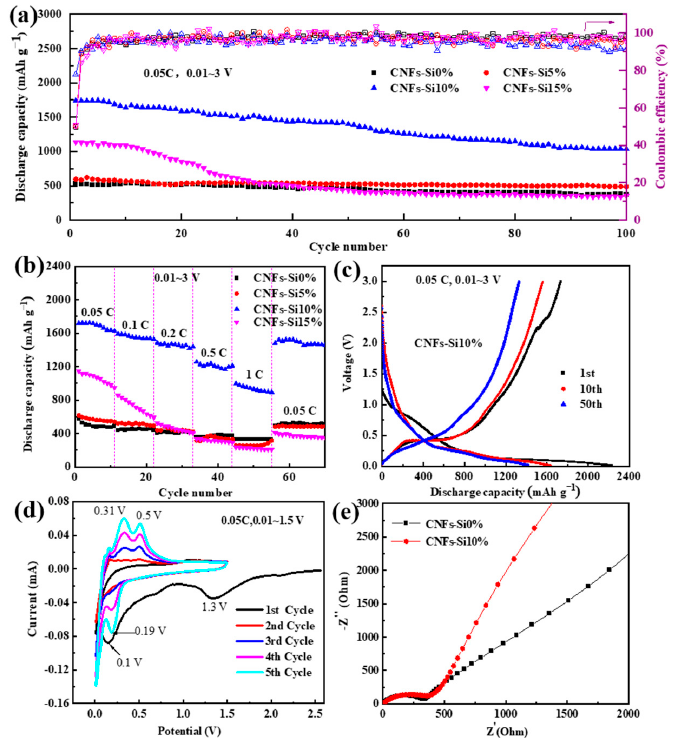
Figure 6. ( a ) Cycle performance and ( b ) rate performance curves of CNFs-Si0%, CNFs-Si5%, CNFs- Si10% and CNFs-Si15% anodes in lithium-ion batteries. ( c ) The charge–discharge curves of the CNFs-Si10% anode, ( d ) CV curves of the CNFs-Si10% anode, and ( e ) Nyquist plots of CNFs-Si0% and CNFs-Si10% anodes in lithium-ion batteries. Table 1. Electrochemical performance of flexible carbon fiber anodes for lithium-ion batteries re- ported in this work.